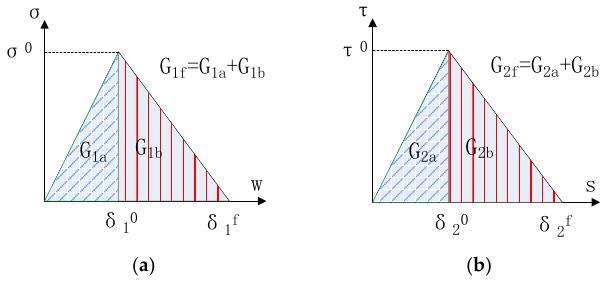
Figure 3. Cohesive zone models for mode I and mode II interface debonding: ( a ) traction-separation law in normal direction (mode I); ( b ) traction-separation law in tangential direction (mode II).